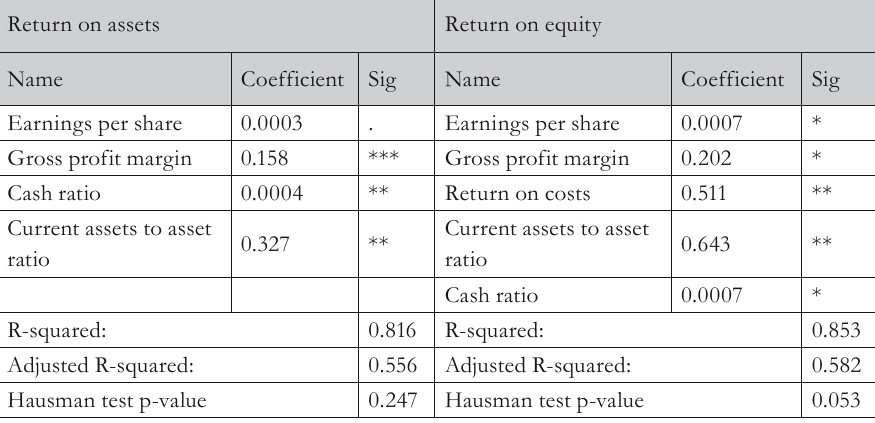
Tab. 4 - Food and grocery sector: significant variables predicting ROA and ROE. Source: author’s own calculation